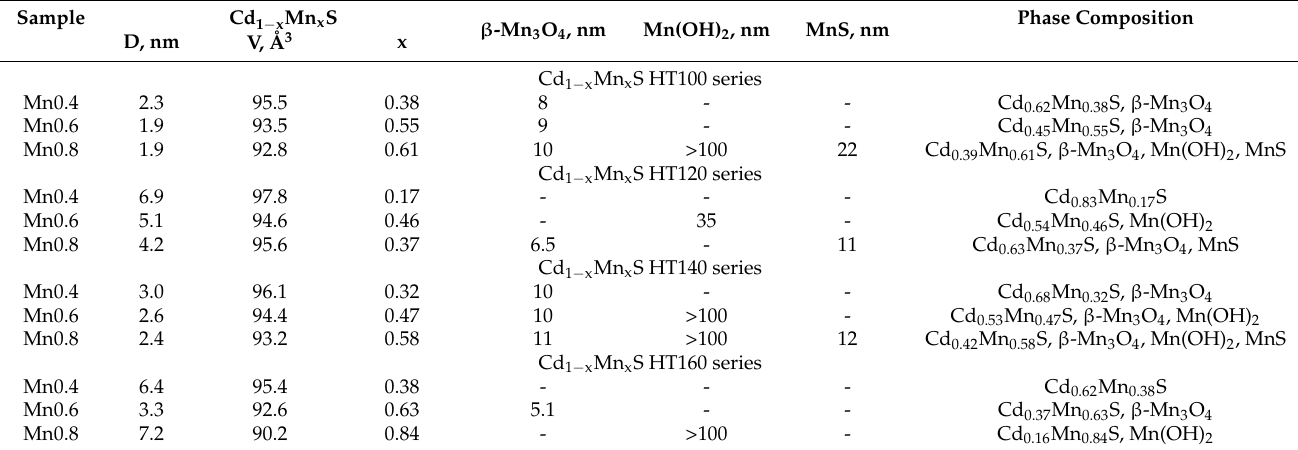
Table 1. Phase composition and lattice parameters of all synthesized